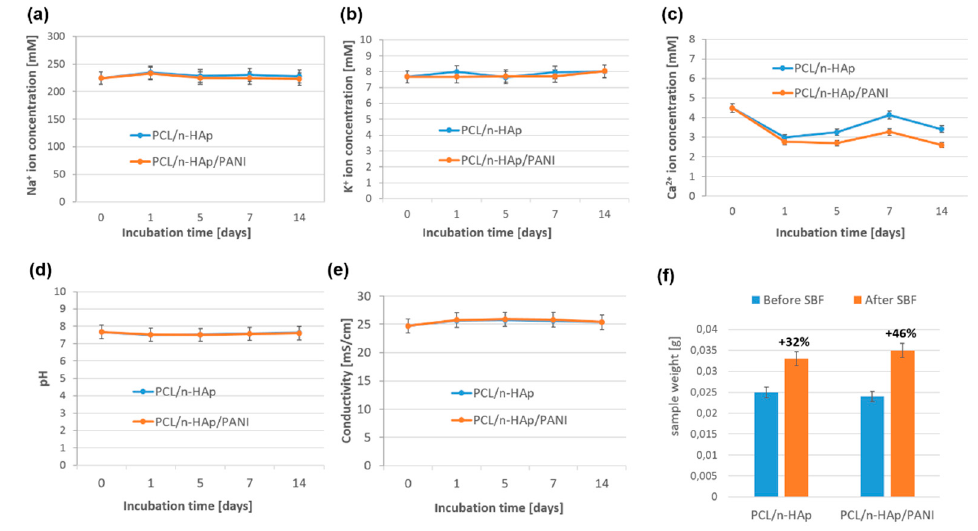
Figure 7. ( a – c ) The Na+, K+, Ca 2+ ion concentration during incubation of the samples in SBF; ( d , e ) pH and conductivity of the SBF solution during incubation of samples. ( f ) The weight of the samples before and after incubation in the SBF fluid.